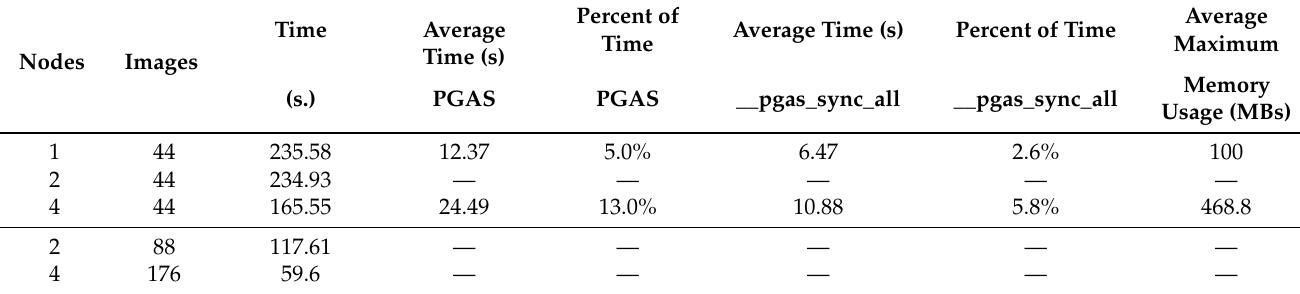
Table 1. Inter- vs. intra-node